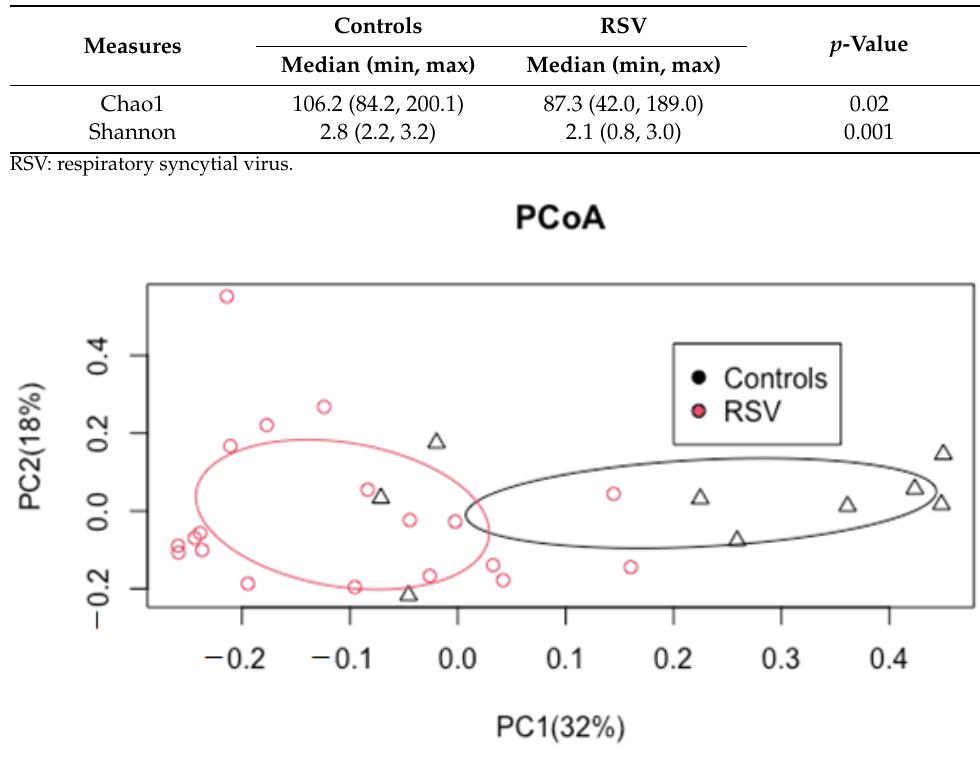
Figure 1. Gastrointestinal bacterial community dissimilarity based on the Bray-Curtis metric. The microbiotas of the control infants are represented by black triangles. The micro- biotas of infants with RSV are represented by red circles. Dots that are closer to each other indicate infants with a more similar gastrointestinal microbiota composition. Ellipses